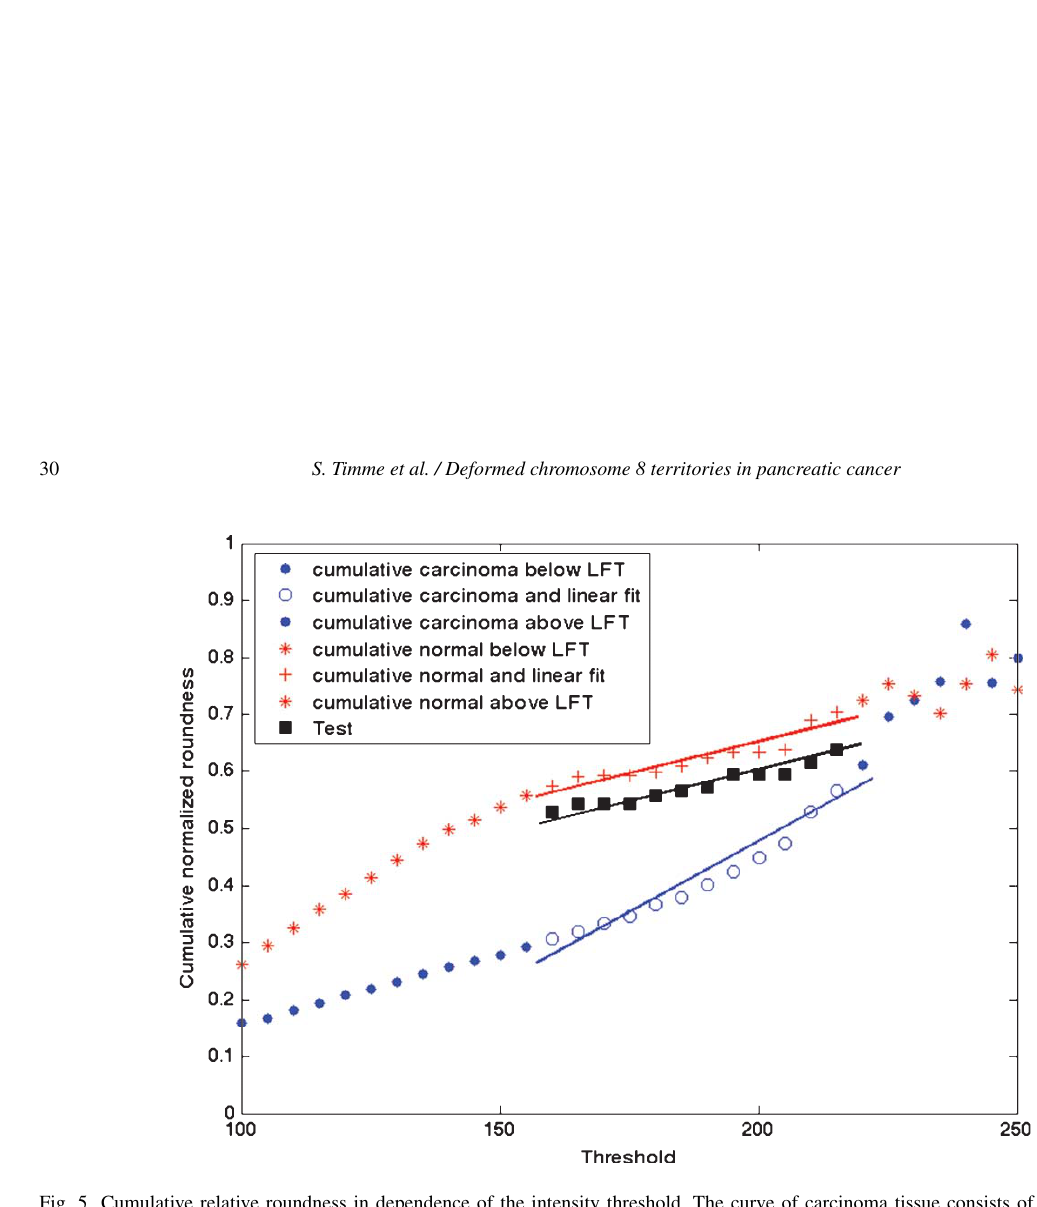
Fig. 5. Cumulative relative roundness in dependence of the intensity threshold. The curve of carcinoma tissue consists of the average of 5 patients, the normal curve of the average of 4 patients. The linear fits shown have been calculated for the values between threshold (LFT) 170 and 230. The mean roundness values based on this linear fit for carcinoma and normal tissue are significantly different. In addition, the values for the test patient are shown and clearly demonstrate that the specimen can be classified as